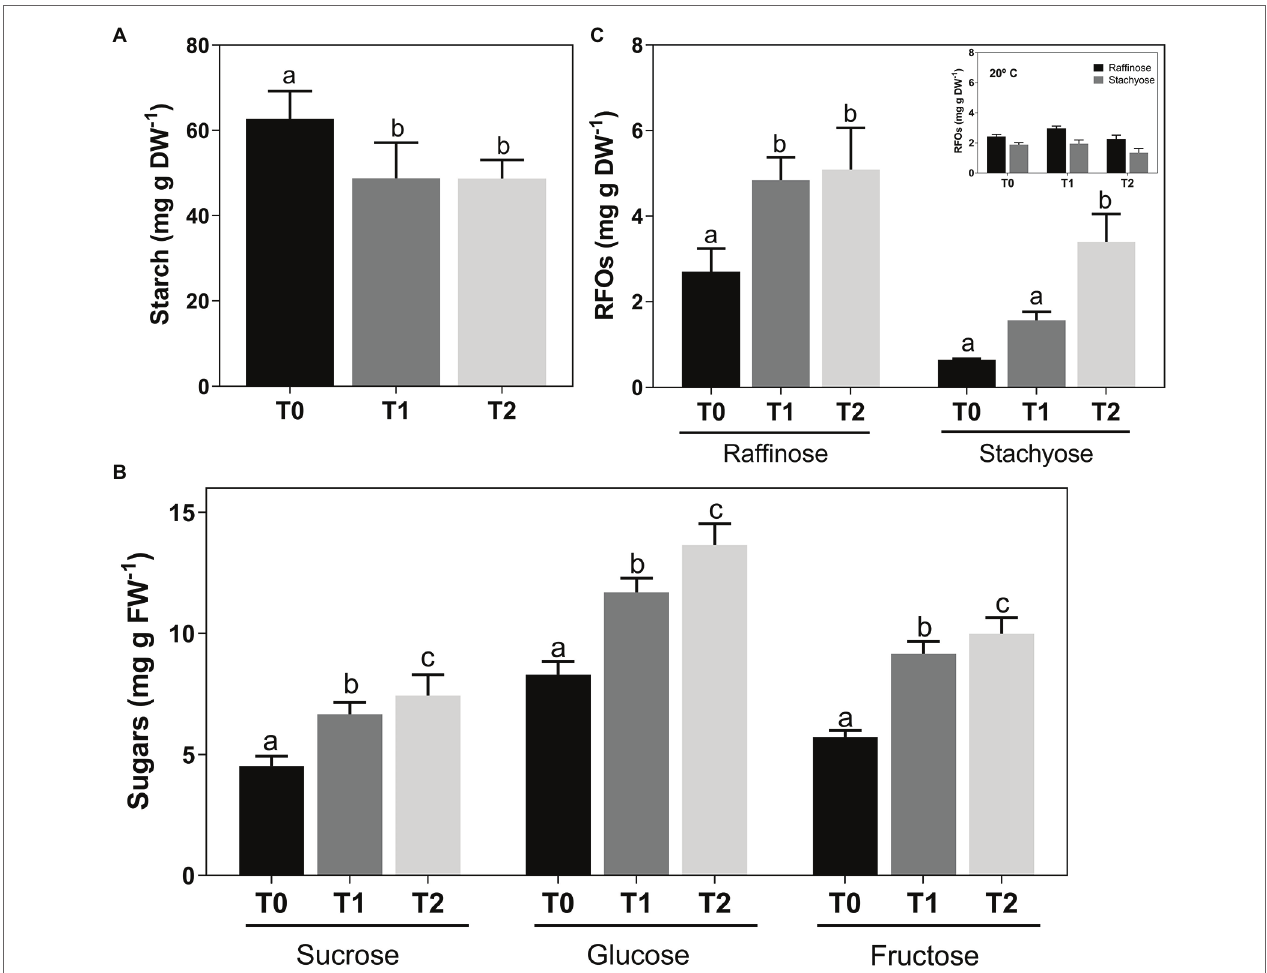
FIGURE 2 | Concentration of sucrose, glucose, and fructose (A) , starch (B) and raffinose, and stachyose (C) in Vitis vinifera cv. Vinhão canes incubated at 4 ° C up to 14 days. Insert, raffinose, and stachyose levels in canes incubated at 20 ° C up to 14 days. Results indicate the mean ± SD of three biological replicates per condition. Different letters stand for significant differences ( p ≤